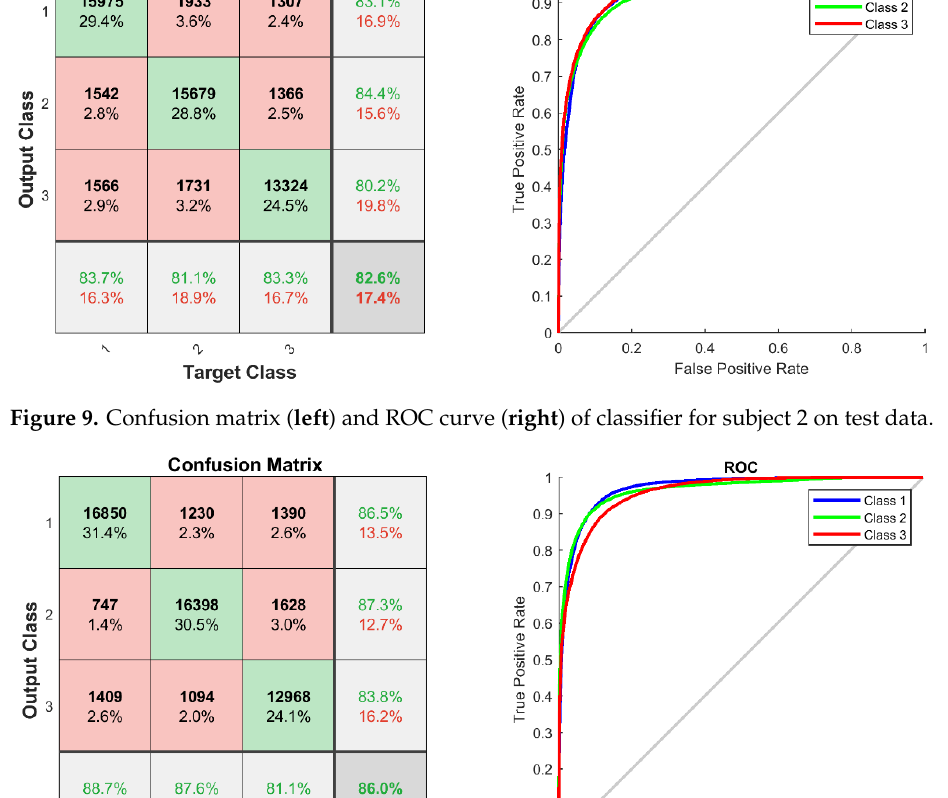
Figure 10. Confusion matrix ( left ) and ROC curve ( right ) of classifier for subject 3 on test data.